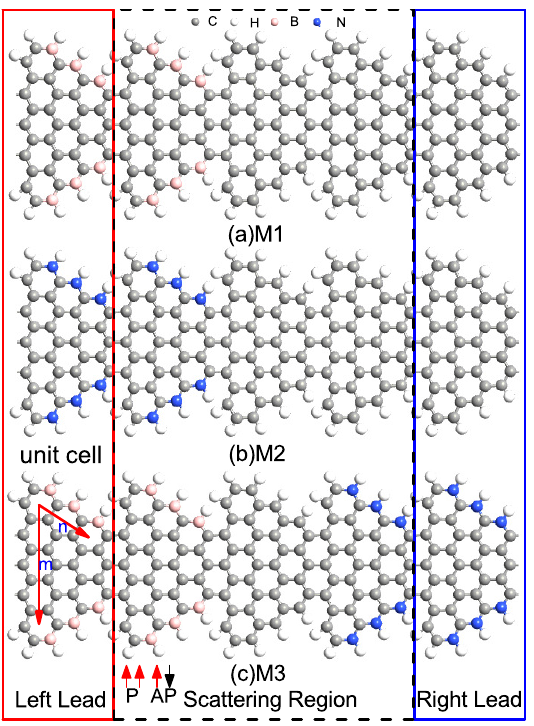
Figure 1. (Color online) The constructed device models for edge-doped STGNRs (m, n), where M1, M2 and M3 correspond to ( a ) left B-doped and right pristine STGNR electrode, ( b ) left N-doped and right pristine STGNR electrode and ( c ) left B-doped and right N-doped electrodes. The black, grey, pink and blue spheres represent the C, H, B, and N atoms, respectively. The red/blue frame indicates the unit cell of left/right electrode, and (m, n) . The red/black arrow indicates the spin-up ( α -spin)/spin-down ( β -spin) states in the electrodes, and P/AP configuration indicates the spin of the left and right electrode is parallel/antiparallel directions,